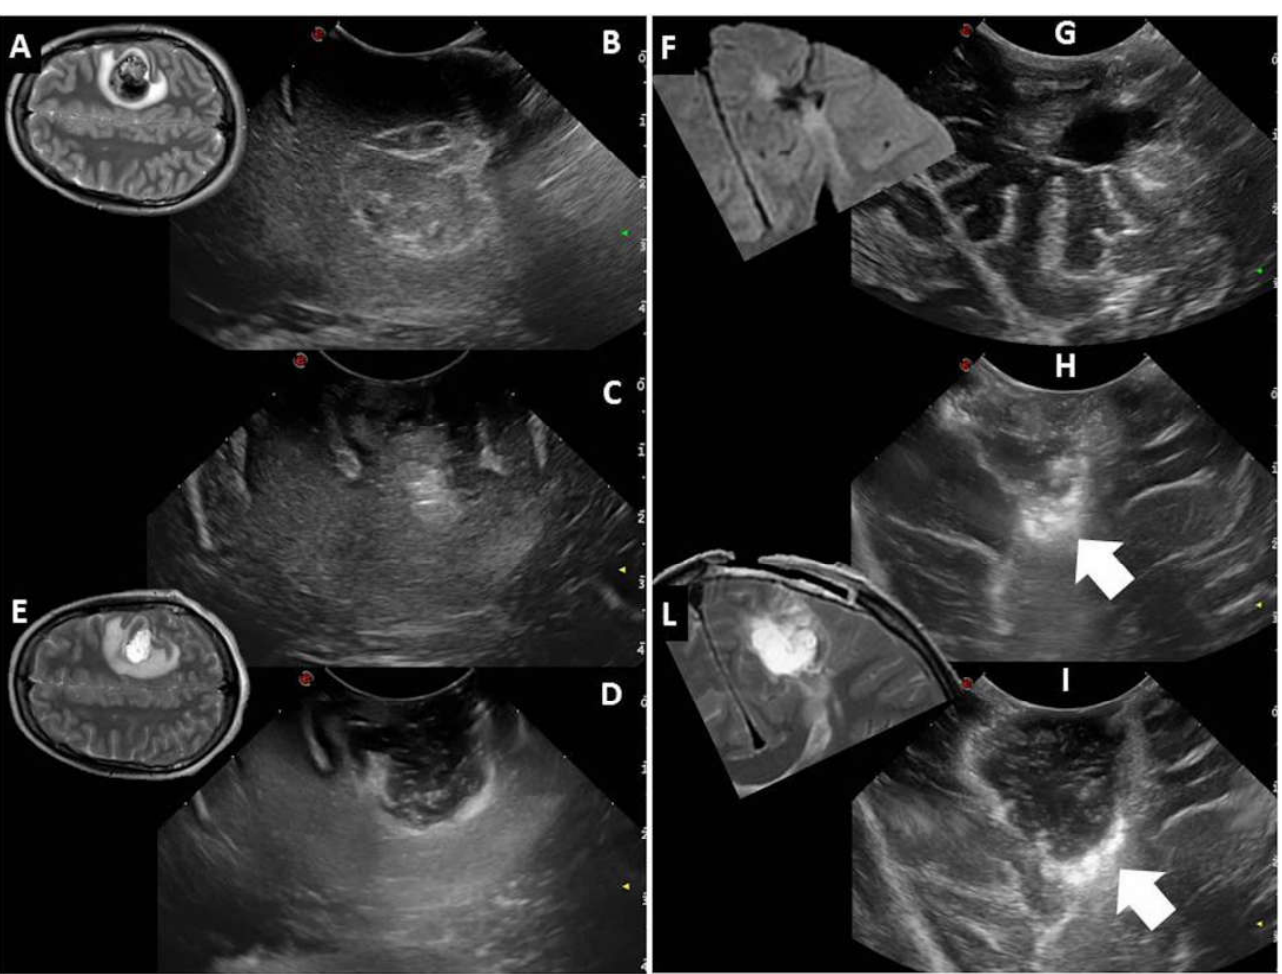
Figure 3. Case #1 (left): Right parietal cavernoma documented by preoperative MR ( A ) and IOUS before surgical resection ( B ). After resection of the lesion, IOUS visualization of the collapsed surgical cavity is limited by surgical artifacts ( C ). The dIOUS allows the distension of the surgical cavity, which is bordered by linear hyperechoic artifacts ( D ). The complete resection of the lesion is concordant with postoperative MR ( E ). Case #2 (right): Left parietal glioneuronal tumor documented by MR ( F ) and IOUS before surgical resection ( G ). After surgical resection of the tumor, IOUS shows a possible residual tumor ( H , arrow). The dIOUS rules out the presence of residual tumor, as the hyperechoic thickening becomes linear during gentle pressure irrigation ( I , arrow). Radical resection is confirmed by postoperative MR ( L ).